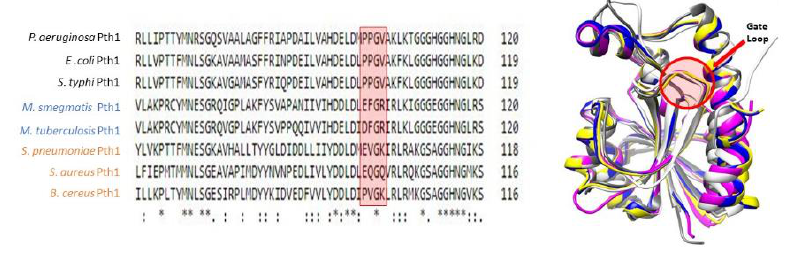
Figure 3. Gate Loop Region of Bacterial Pth1. ( Left ) Multiple sequence alignment of the gate loop region reveals a conserved motif within phylogenetic clades. * indicates identicle residues. ( Right ) The gate loop structure maintains a highly conserved fold following superimposition of crystal structures.